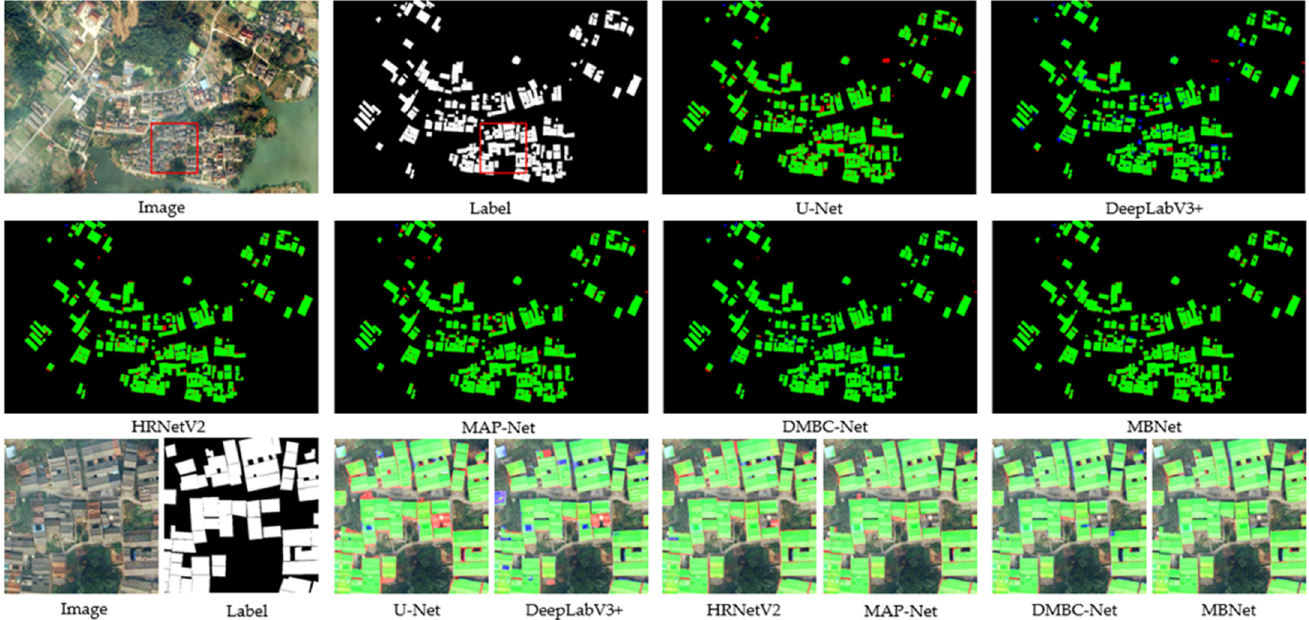
Figure 12. Segmentation results of the different SOTA methods on the hilly landform scene 1 test dataset. The bottom row is a close-up view of the red box.